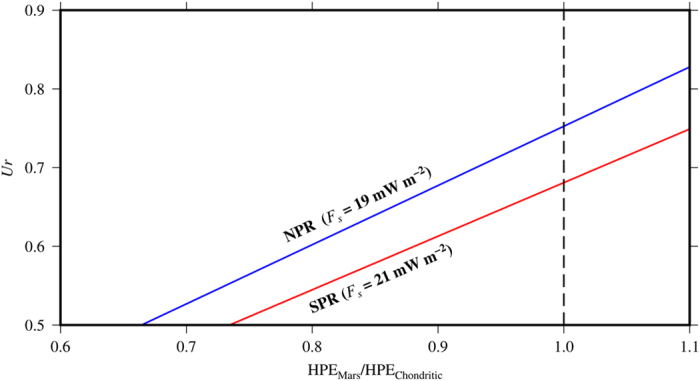
Urey ratio as a function of the HPEMars/HPEChondritic ratio.The blue and red lines represent, respectively, the Ur values obtained from average heat flows obtained by the FNPR- and FSPR-based models.